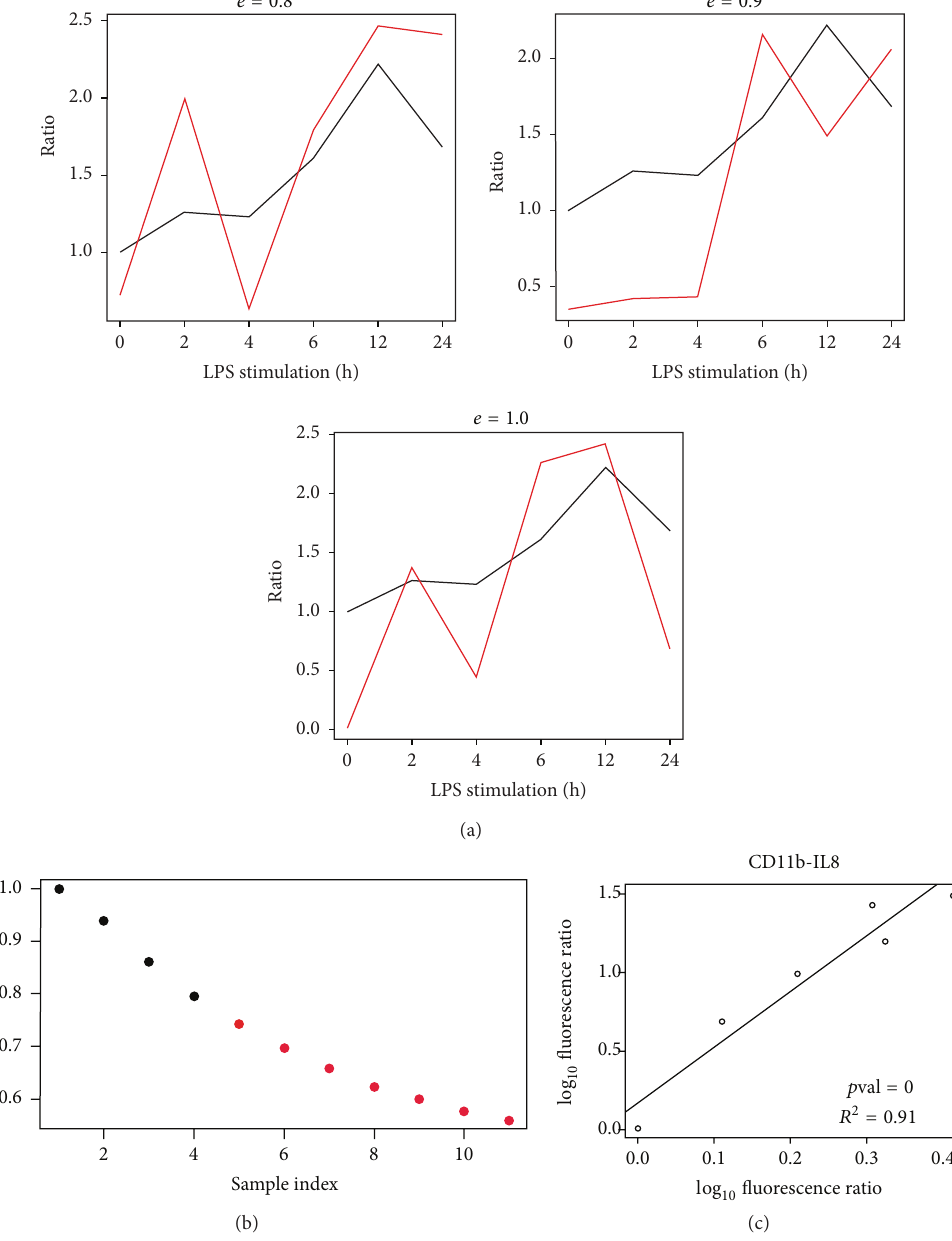
Figure4:Linearfittingapproachtoinvestigatetimeseriesofdegranulationandcytokinesecretion.(a)Simulationswereperformedtofindthe optimal threshold for RSQ value. After introducing perturbations ( 𝑒 value) to the kinetic profiles, the linear fitting decreases in significance. (b) Plot of average RSQ deriving from simulations against augmenting 𝑒 values. (c) Perfectly linear fitting model in which the behaviour of IL8 is correlated to CD11b. Due to its 𝑝 value of 0 and RSQ of 0.91, the correlation between IL8 and CD11b corresponds to a perfect linear fitting